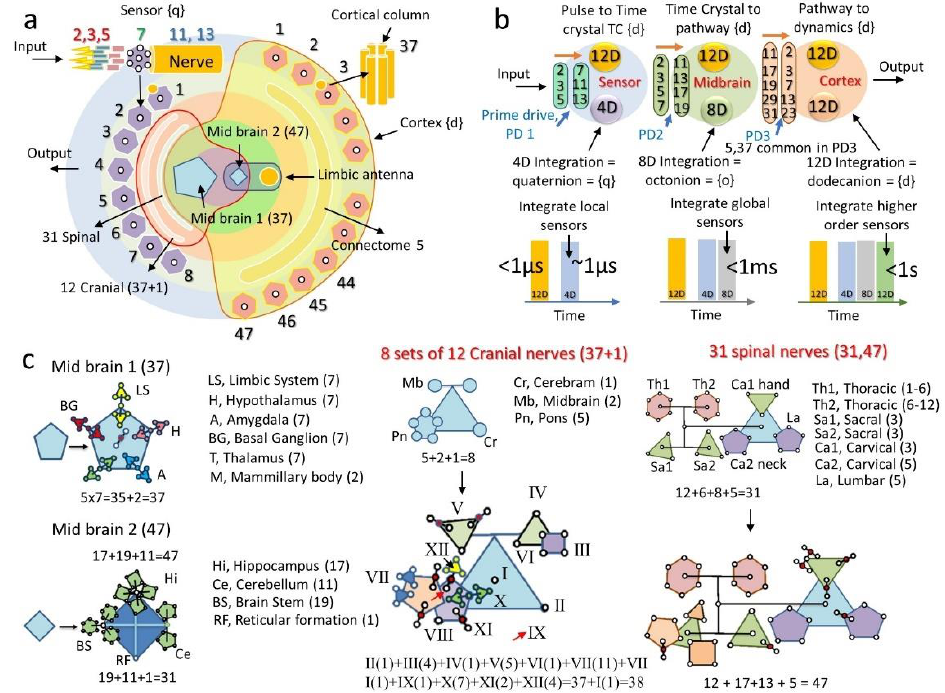
Figure 4. ( a ) A spherical model of a human brain. The left half is made of 8 classes of sensors. Each sensor processing primes 2 to 13. Sum of cranial and spinal nerves is 43, a prime, passes through two basic parts of the mid brain one represents prime 17 and the other represents prime 47, which equals to the cortex functional classification with Brodmann’s 47 regions [41]. Explanations of the primes are given in the panel ( c ). ( b ) Two rows explain the flow of primes with the data structure in the brain (top) and data structure with the operational time domain. ( c ) The components used in the generic brain model of panel a is explained in the panel c. Cranial nerves and the spinal nerves classifications are detailed in the right panel.